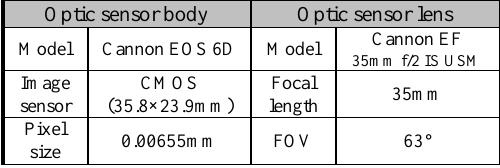
Table 1. Specifications of optic sensor body and lens